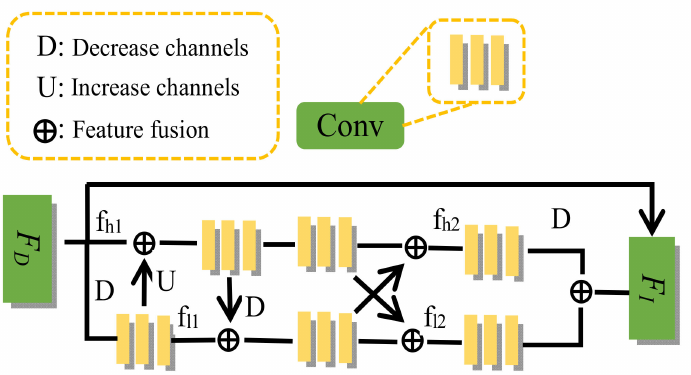
Figure 5. The structure of the interactive residual